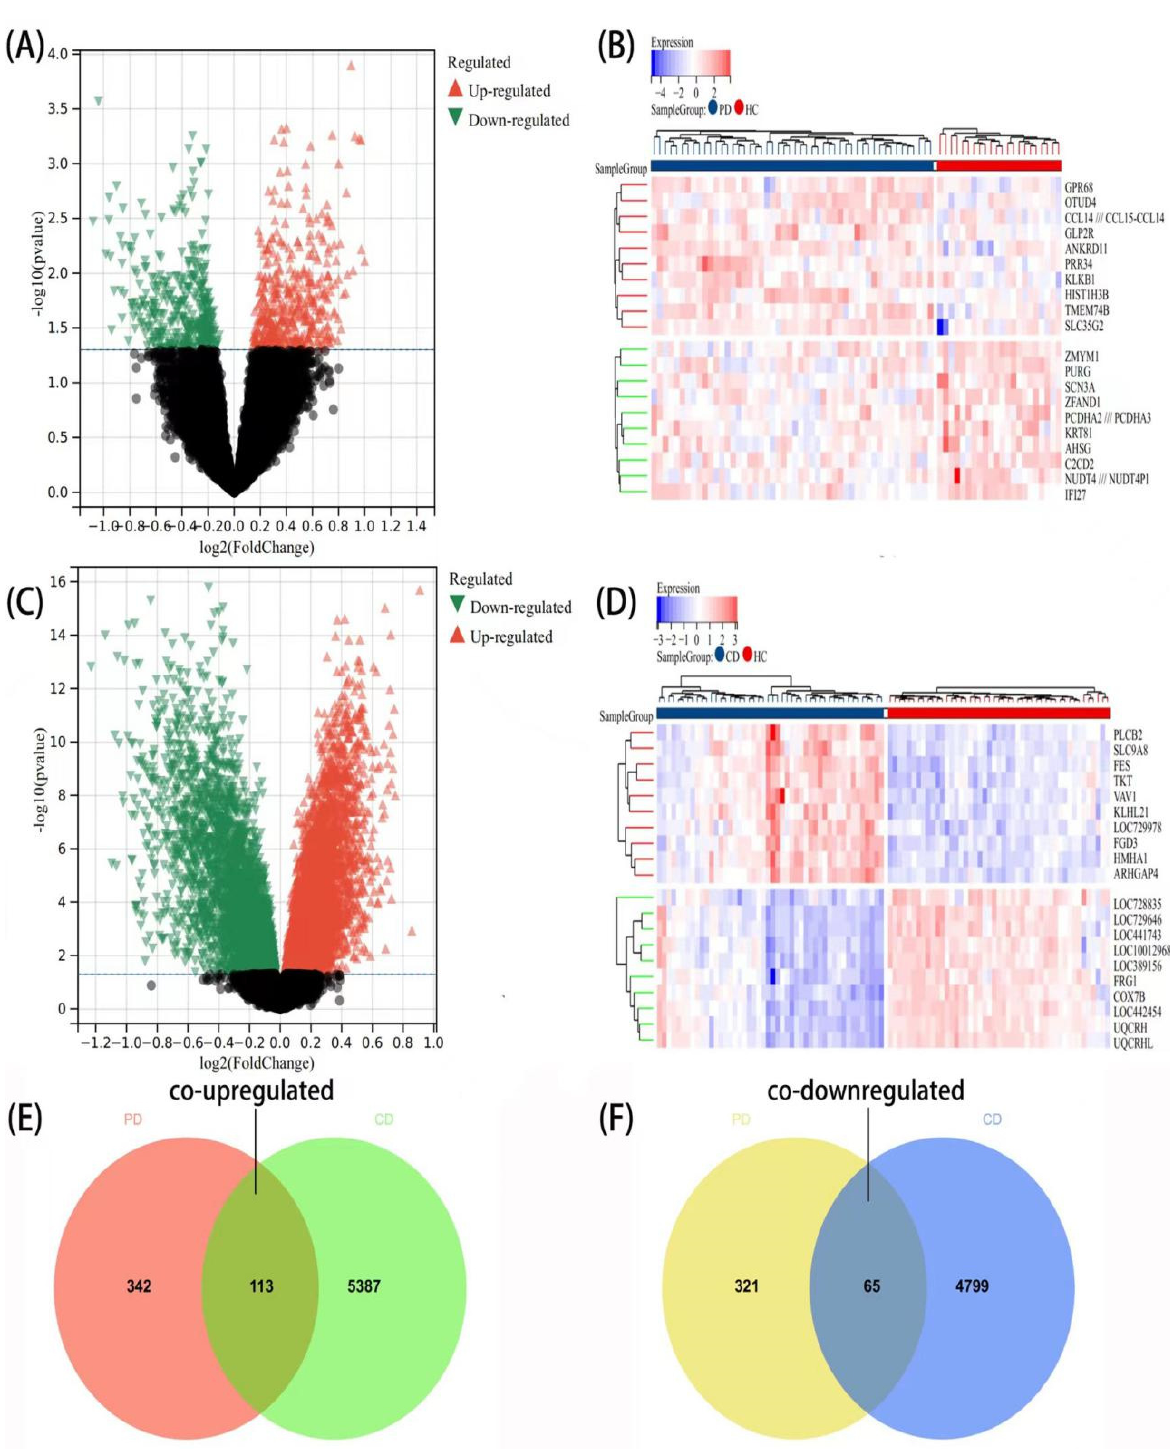
Figure 2. Identification of gene expression profiles in the two datasets. ( A ) The volcano map showed the DEGs between PD and HC group. Upregulated genes are marked in light red; Downregulated genes are marked in light green. The threshold was set to |log2FC (fold change)| > 0, and p value < 0.05. ( B ) The cluster heat map of top 20 DEGs between PD and HC group. ( C ) The volcano map showed the DEGs between CD and HC group. ( D ) The cluster heat map of top 20 DEGs between CD and HC group. ( E ) The Venn diagram showed an overlap of 113 co-upregulated DEGs. ( F ) The Venn diagram indicates an overlap of 65 co-downregulated DEGs.